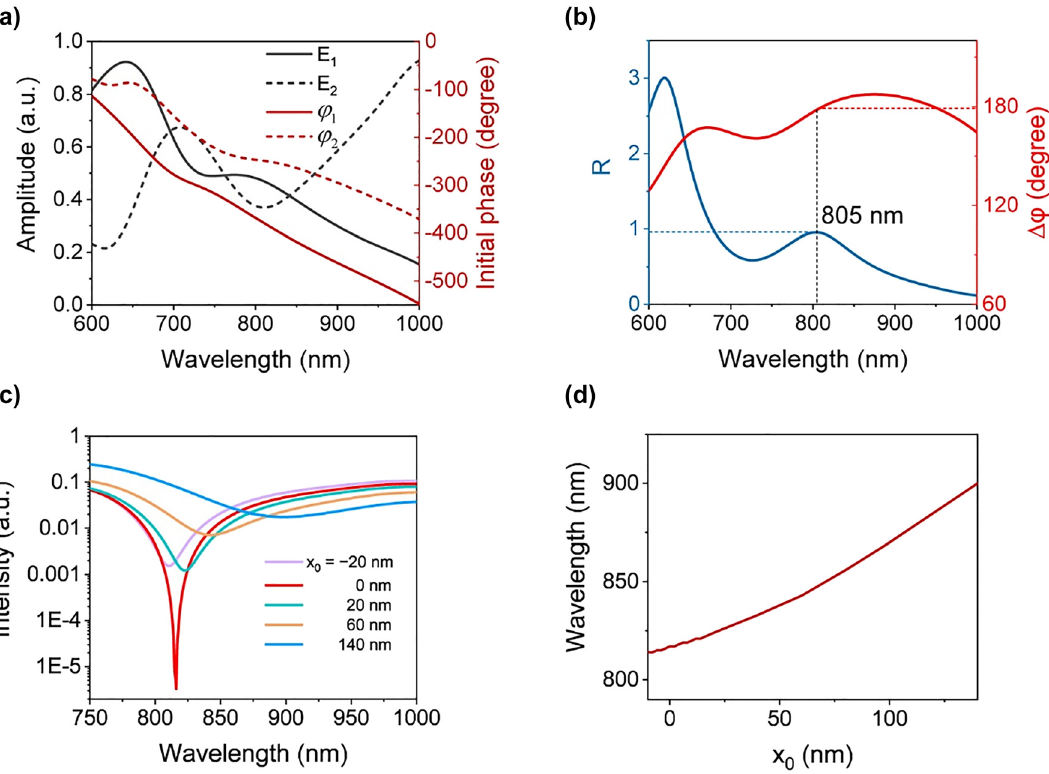
Figure 2: Calculation results of the nanoscale displacement sensor. (a)Calculatedelectricfieldamplitudes(solidlines)andtheinitialphase(dashedlines)atcentersofthetwoantennasinthe xy planeversusthe wavelength. (b) Calculated amplitude ratio of SPPs launched by the two antennas (blue line) and Δ φ (red line) versus the wavelength for d = 120 nm. (c) Calculated output spectra for various displacements. (d) Calculated extinction wavelength versus the